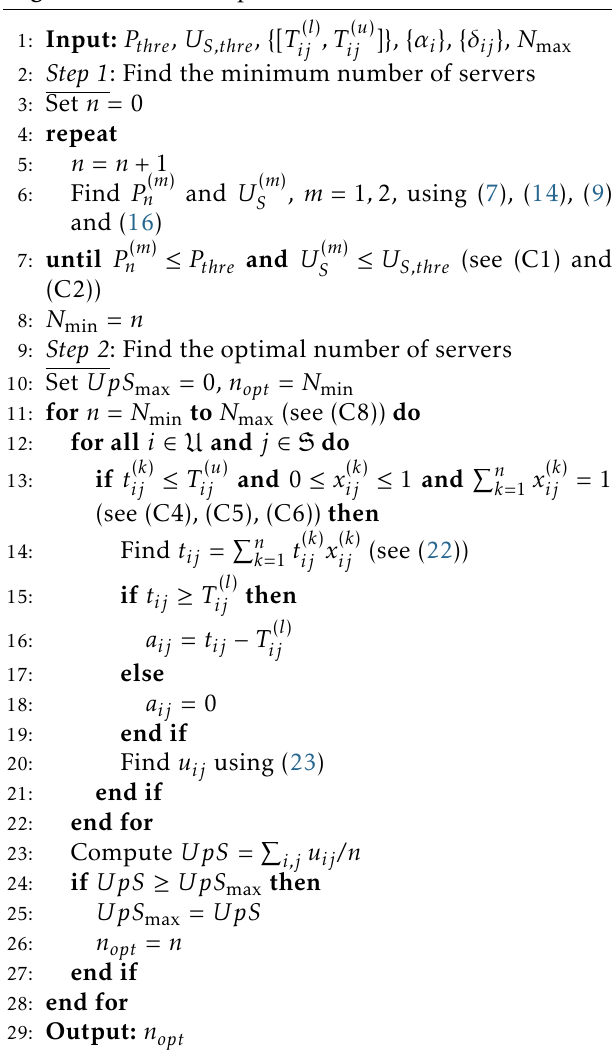
Algorithm 1 Two-Step Iterative